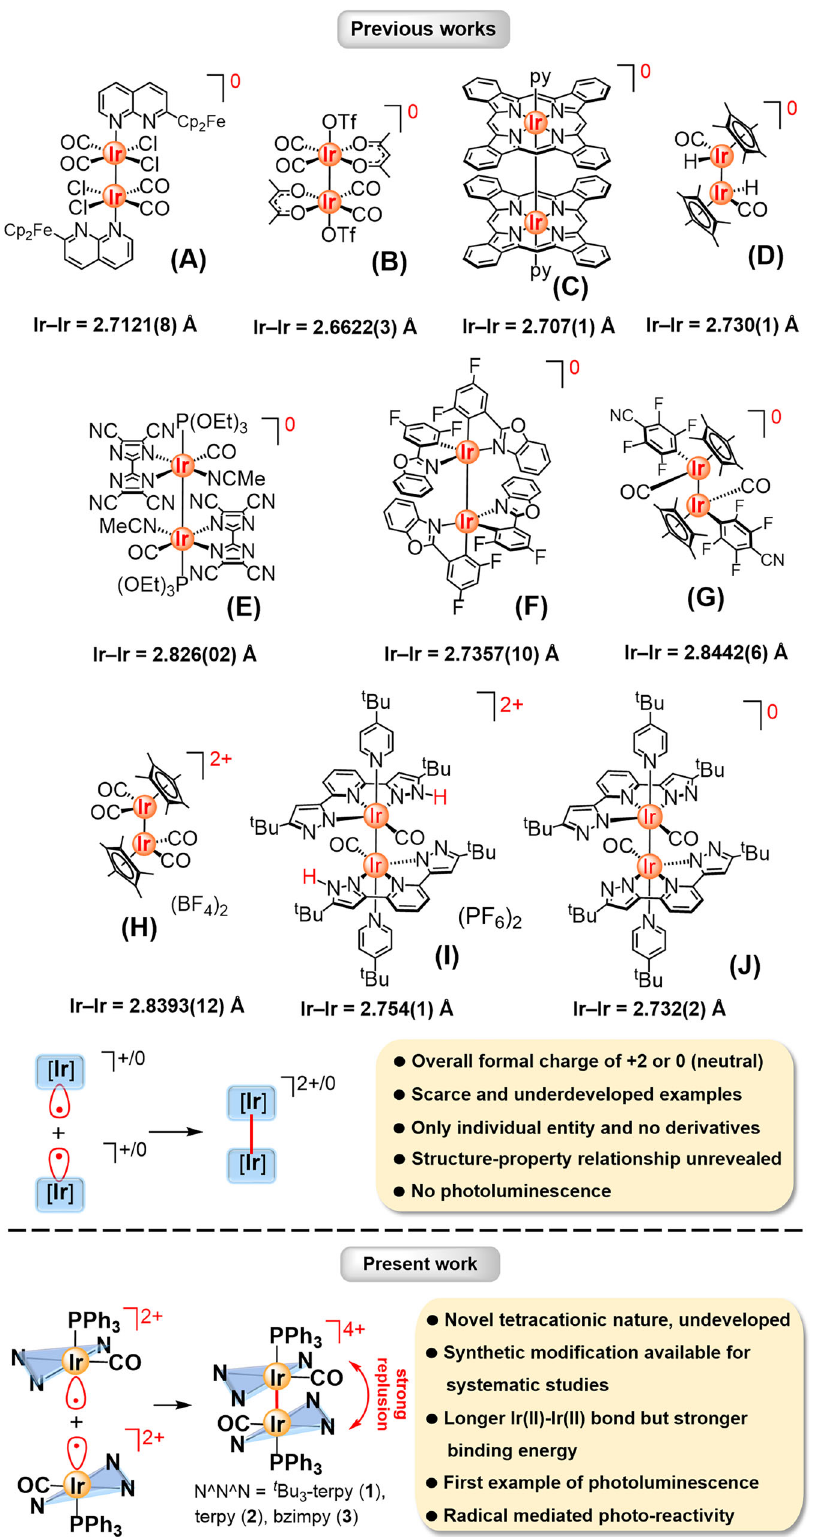
Fig. 1 Previous examples with neutral or dicationic charge and this work with tetracationic charge. Previous works ( A – J ). Diiridium(II) complexes with unsupported Ir(II) – Ir(II) bond, formed from two d 7 Ir(II) fragments and the uniqueness of tetracationic diiridium(II) complexes ( 1 – 3 ) in this